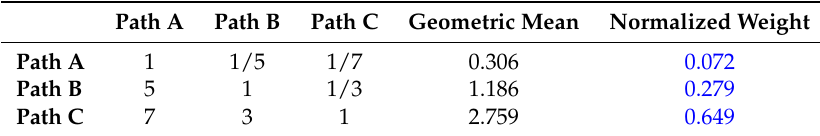
Table 4. Weight Evaluation for ‘Steepness’.